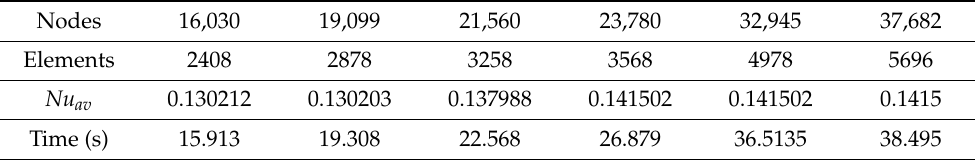
Figure 4. Grid sensitivity tests for Pr = 0.71, Ha = 100 and Ra = 10 5 . Table 1. Grid sensitivity tests at Pr = 0.71, Ha = 100 and Ra = 10 5 . Nodes